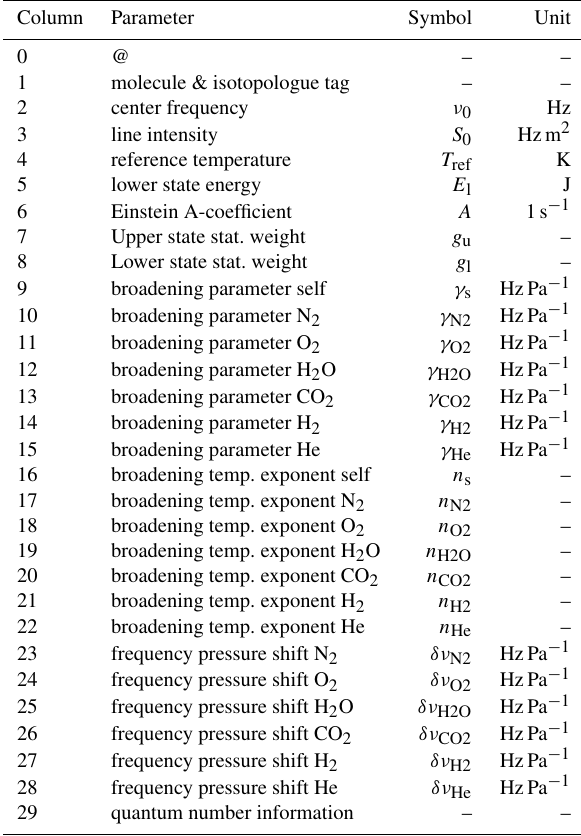
Table 3. ARTSCAT-4 spectroscopic line data format. Row 0 gives the line entry start marker; the following parameters are separated by one or more